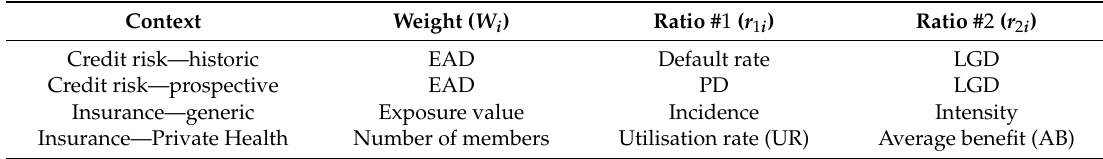
Table 2. Example contexts for the basic